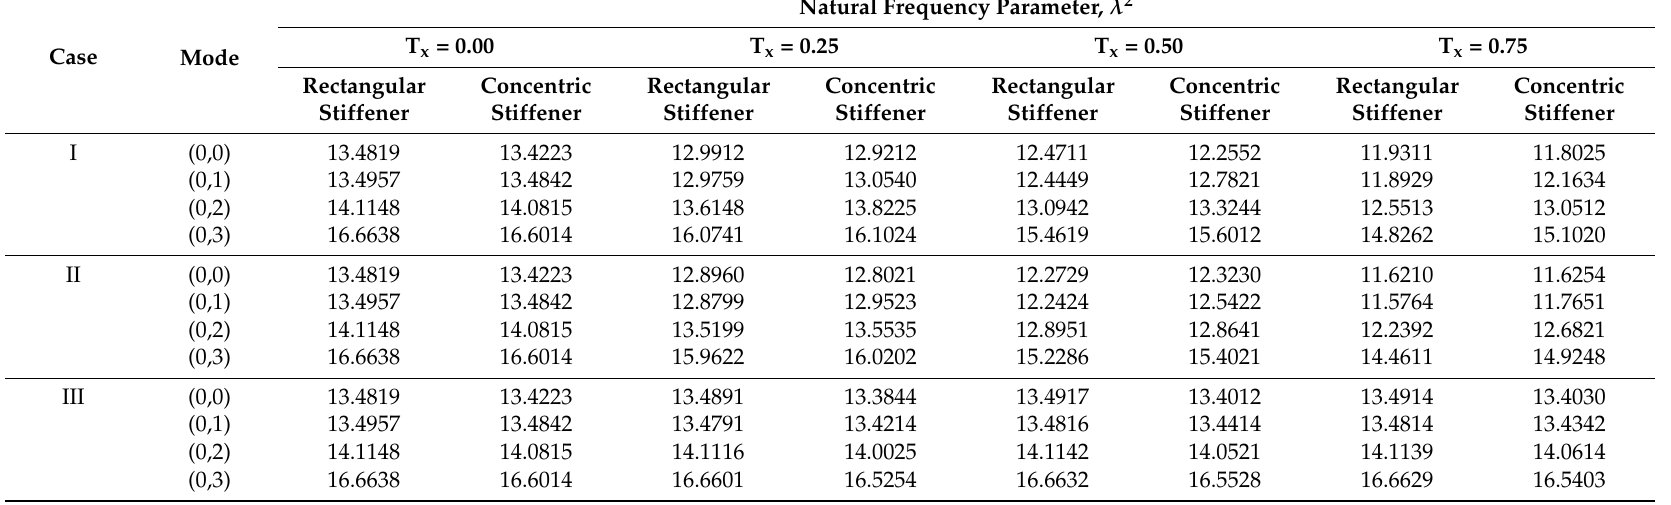
Table 4. Numerical comparison of natural frequency parameter λ 2 of a plate with 1 rectangular and 1 concentric stiffener patch for different thickness variations and for different taper ratios T x